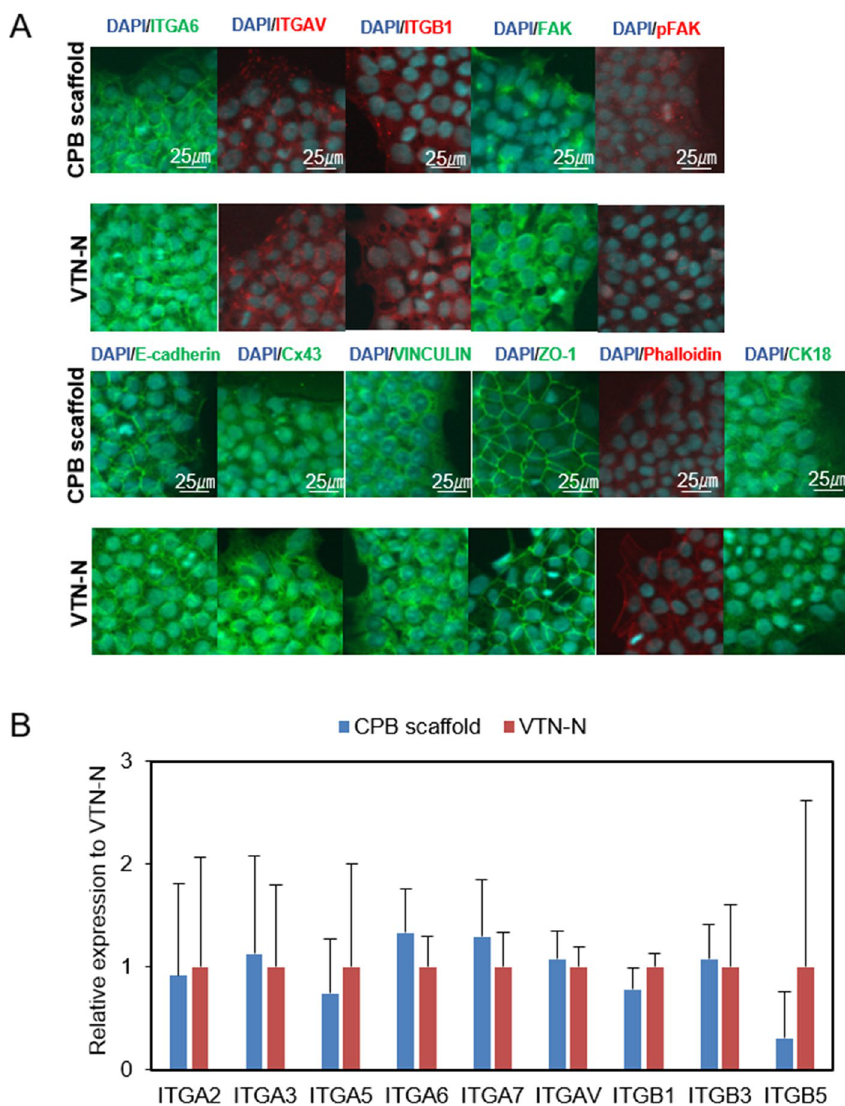
Figure 7. Immunostaining and RT-qPCR of Integrin and other factors. ( A ) Immunofluorescent staining of integrins, focal adhesion molecules, and cytoskeleton proteins of 253G1 cells after more than 10 passages on CPB scaffold or VTN-N. Integrins and other factors are shown in green, red, or orange, and DAPI is shown in blue. Scale bars indicated in the figure. ( B ) Result of RT-qPCR of the relative gene expression of integrins normalized to expression on VTN-N. The vertical axis shows the fold change to VTN-N. Data are presented as mean ± SD of three independent experiments. (* P < 0.05 compared to